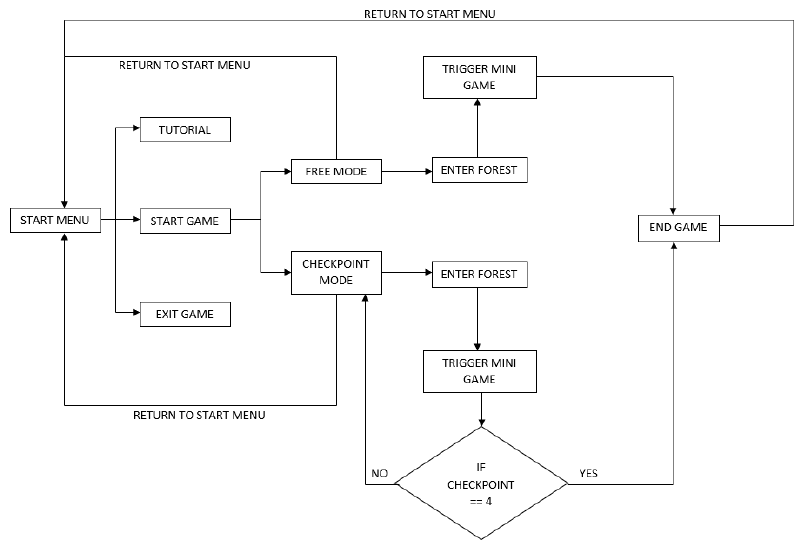
Figure 2. Detailed flowchart of the application. Table 1. The details of forest therapy activities implemented in the application during the prototype stage.